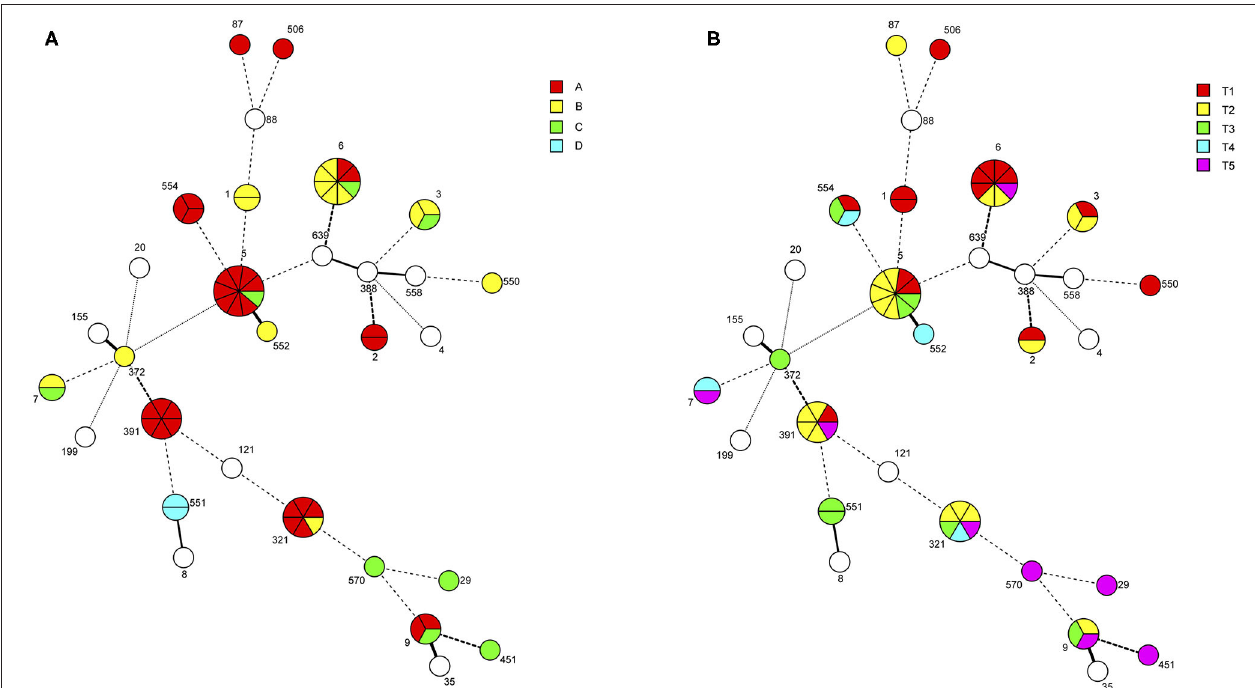
FIGURE 1 | Minimum spanning tree of strains isolated from four turkey processing plants in the United States over a 3-year sampling period. The minimum spanning tree (MST) was constructed using the seven-locus MLST scheme in Bionumerics as described in Materials and Methods. Each circle corresponds to the indicated sequence type (ST). The sections within the circles represent individual strains with a given ST. Circles shown in white are from outside the current study and were included for scaffolding the MST. STs are separated by branches based on seven-locus MLST similarity: one-allele difference (thick solid line), two-allele differences (thin solid line), three-allele differences (thick dashed line), four-allele differences (thin dashed line), more than four-allele differences (thin dotted line). (A) Individual strains are color-coded based on plant of origin: Southeastern USA (Plant A), Northeastern USA (Plant B), Midwestern USA 1 (Plant C), and Midwestern USA 2 (Plant D). (B) Individual strains are color-coded based on isolation date: (T1), September 2003-February 2004; T2, March 2004-August 2004; T3, September 2004-February 2005; T4, March 2005-August 2005; T5, September 2005-March